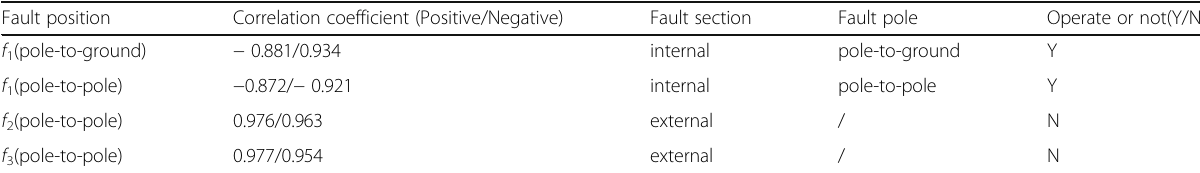
Table 1 Protection results